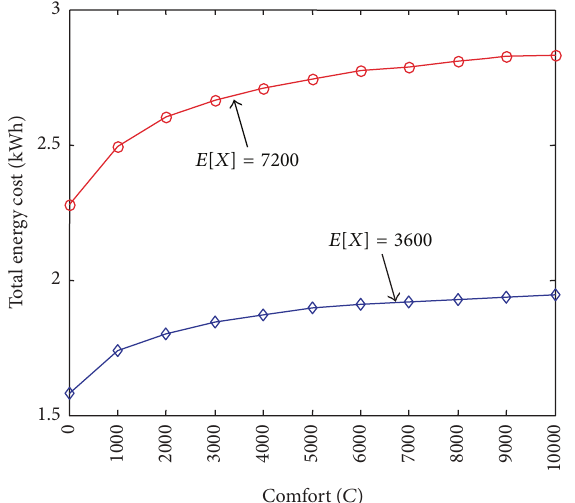
Figure 9: Total energy cost versus 𝐶 𝑖 . The occupation time of zone I is Gamma distributed.